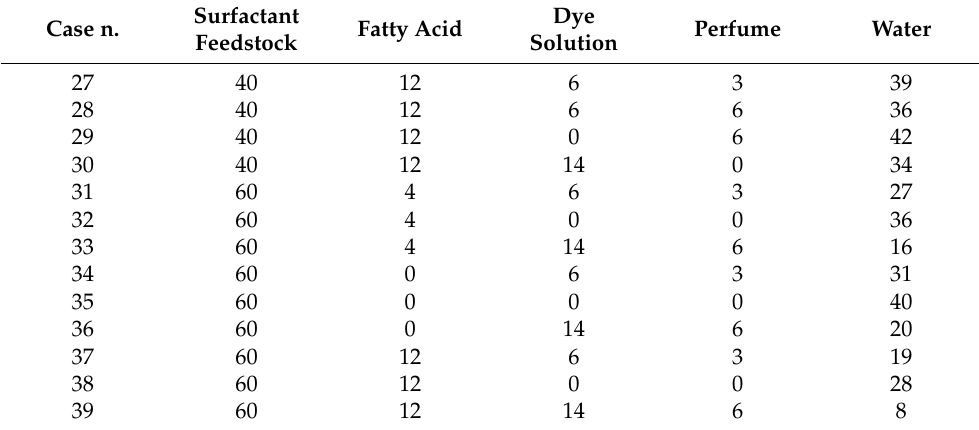
Table 2. Cont. Case